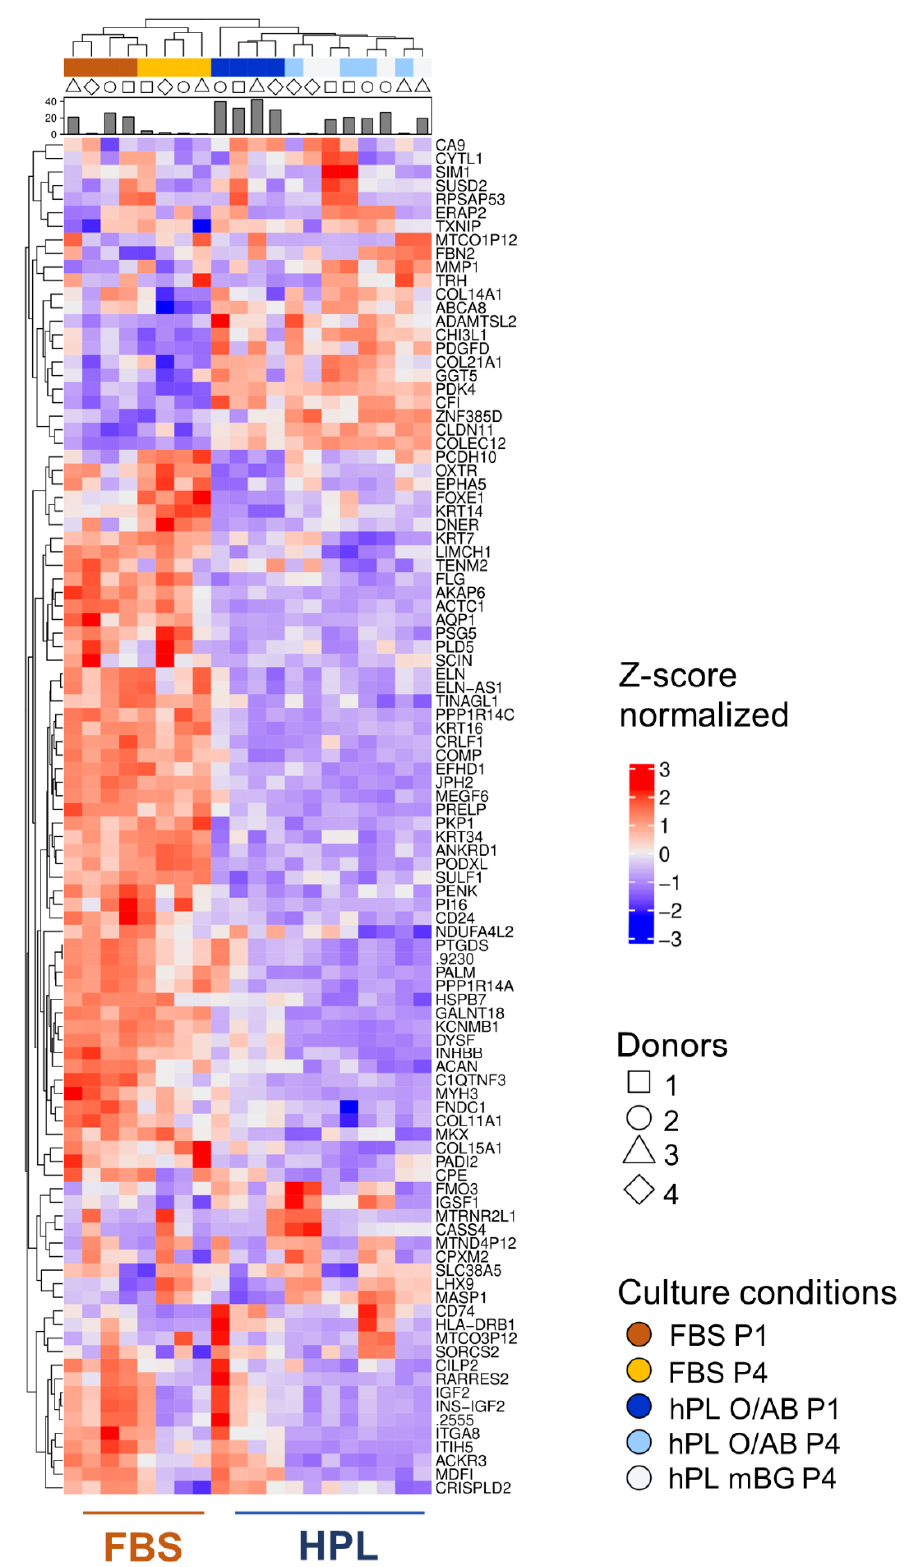
Figure A4. Hierarchical clustering heatmap with expression values of the top 100 most variable genes. Gene expression values were row Z-score normalized where lower expression is denoted by blue and higher expression by red color as shown in the legend above. FBS samples cluster together and HPL samples cluster together, passages have less influence.